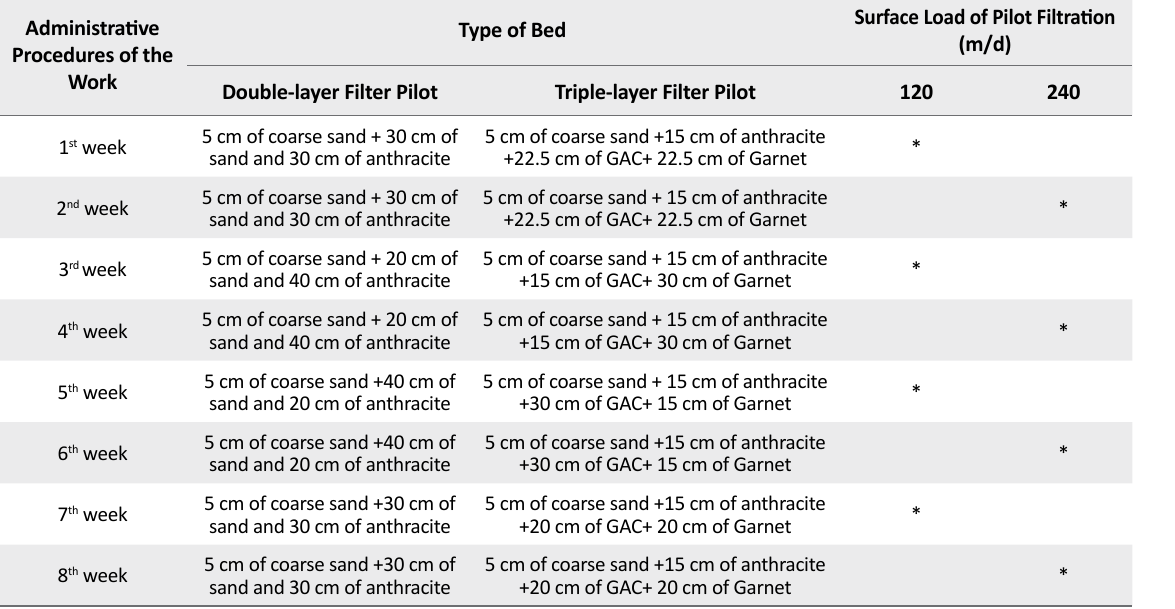
Procedures of the